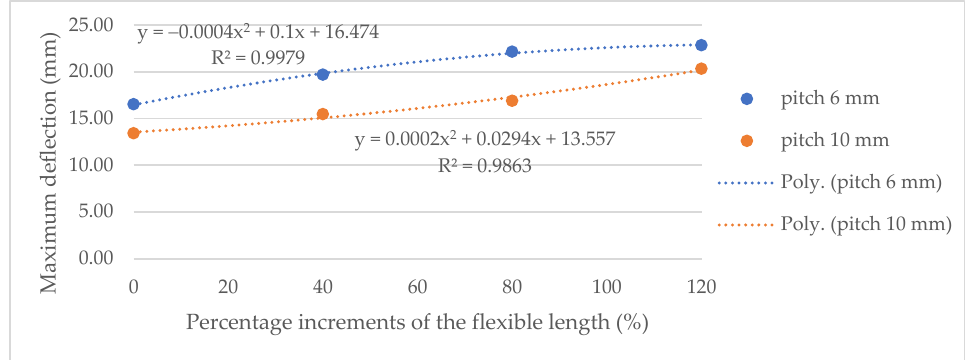
Figure 13. The variation in the maximum deflection with an incremental increase in the flexibilization length, for two values of the model pitch.